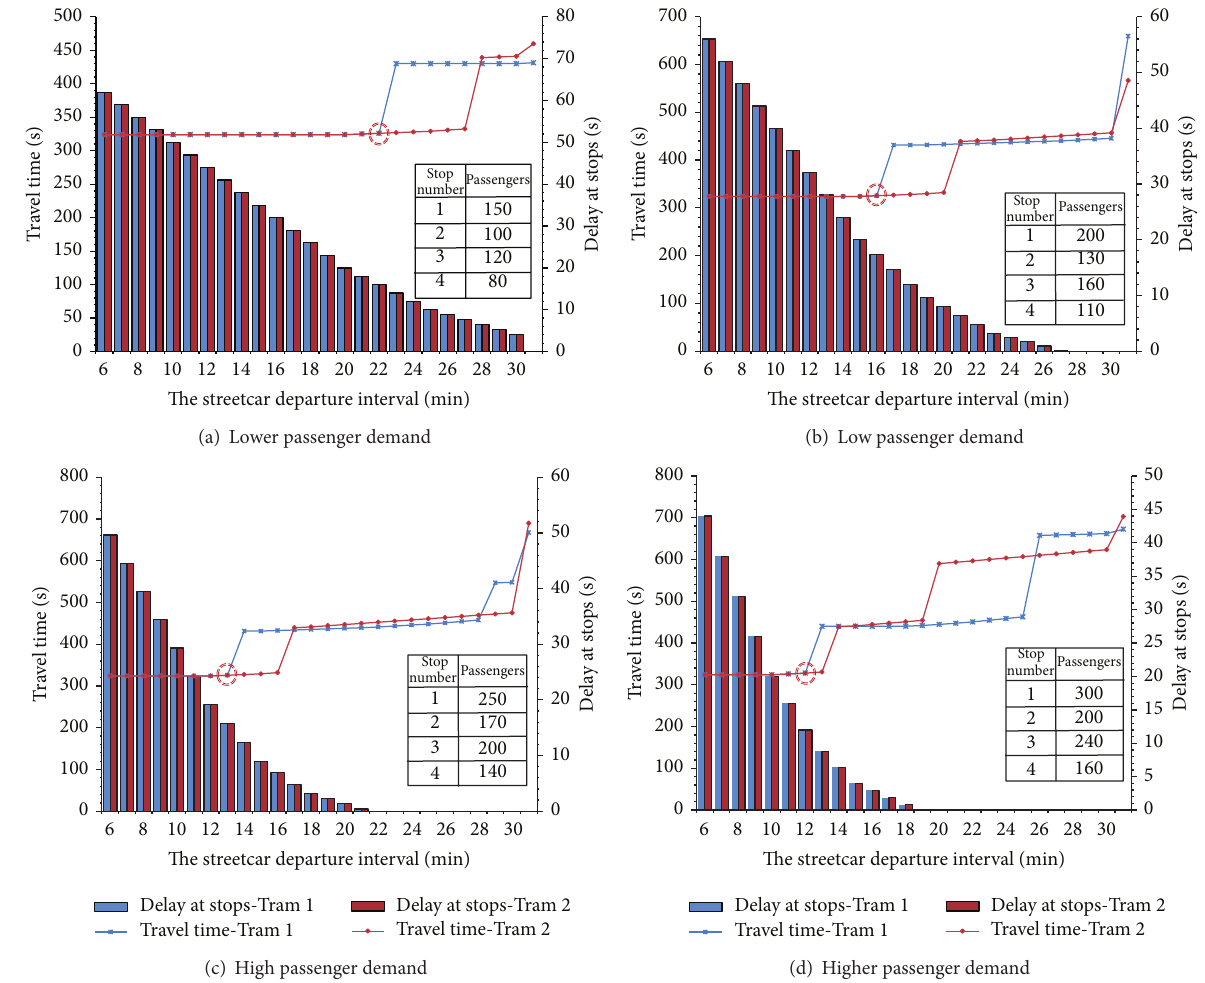
Figure 5: Impacts of streetcar departure intervals on streetcar system